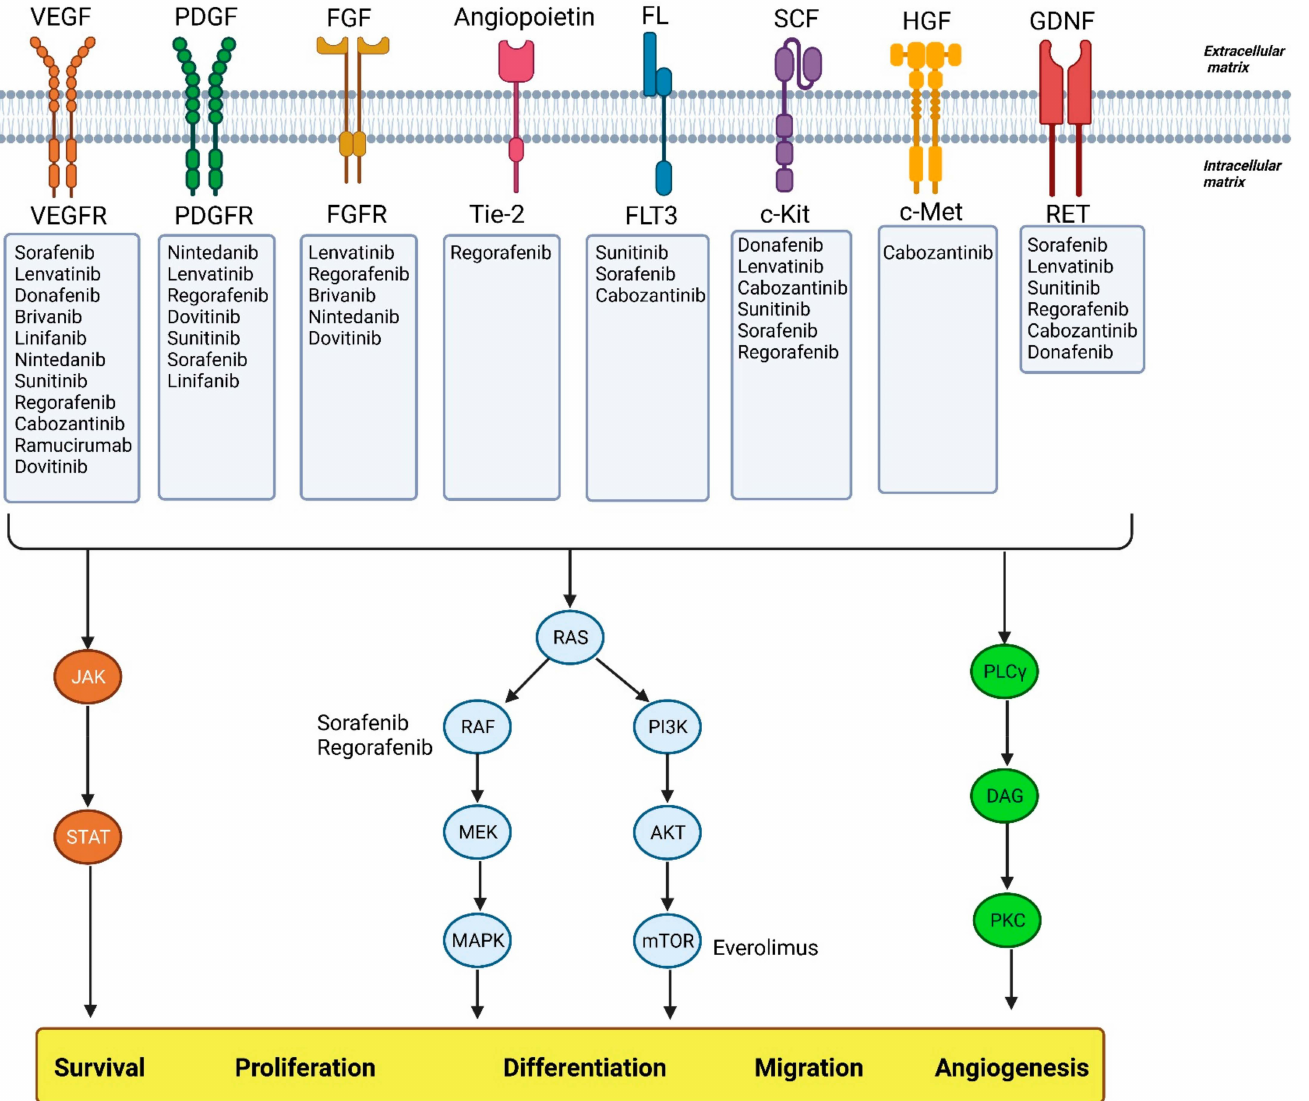
Figure 2. Agents used in targeted therapy of HCC and their different pathways. Abbreviations: VEGF: vascular endothelial growth factor; VEGFR: vascular endothelial growth factor receptor; PDGF: platelet-derived growth factor; PDGFR: platelet-derived growth factor receptor; FGF: fibroblast growth factor; FGFR: fibroblast growth factor receptors; Tie-2: an angiopoietin receptor; FL: Fms-like tyrosine kinase 3 ligand; FLT3: Fms-like tyrosine kinase 3; SCF: stem cell factor; HGF: hepatocyte growth factor; c-Met: mesenchymal-epithelial transition factor; GDNF: glial cell-derived neurotrophic factor; JAK: Janus kinases; STAT: signal transducer and activator of transcription proteins; Ras: rat sarcoma virus; Raf: rapidly accelerated fibrosarcoma; MEK: mitogen-activated protein kinase; MAPK: mitogen activated protein kinases; PI3K: phosphoinositide 3-kinases; AKT: protein kinase B; mTOR: mammalian target of rapamycin; PLC γ : phospholipase C γ ; DAG: diacylglycerol; PKC: protein kinase